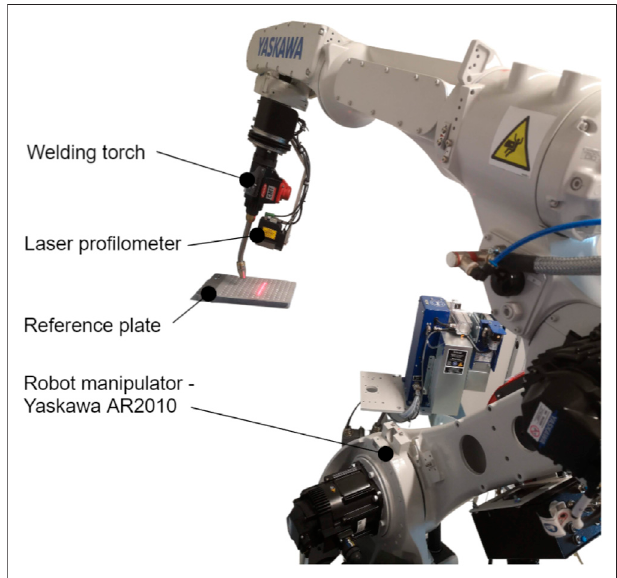
FIGURE 1 | Robotic welding system with a laser pro fi lometer during the measurement of the reference plate that is used for system